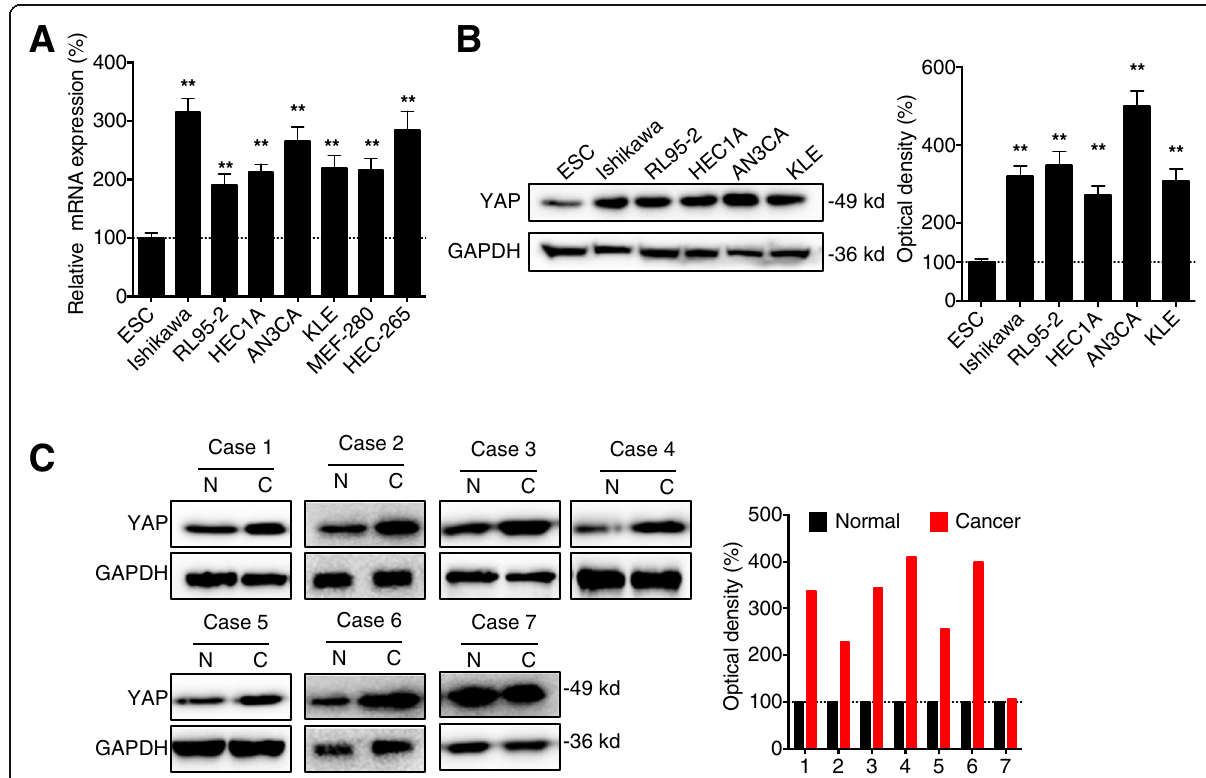
Fig. 1 The expression of YAP is upregulated in EC cells and tissues . ( a ) The mRNA expression of YAP in human EC, ESC, and non-transformed endometrial cell line of epithelial origin such as MEF-280 and HEC-265 cells were measured by qRT-PCR; ( b ) The protein expression of YAP in human EC and ESC cells was measured by western blot analysis (left) and quantitatively analyzed (right); ( c ) The protein expression of YAP in seven cases of EC tissue and paired adjacent normal tissues was measured by western blot analysis (left) and quantitatively analyzed (right). Data are presented as means ± SD of three independent experiments. ** p < 0.01 compared with